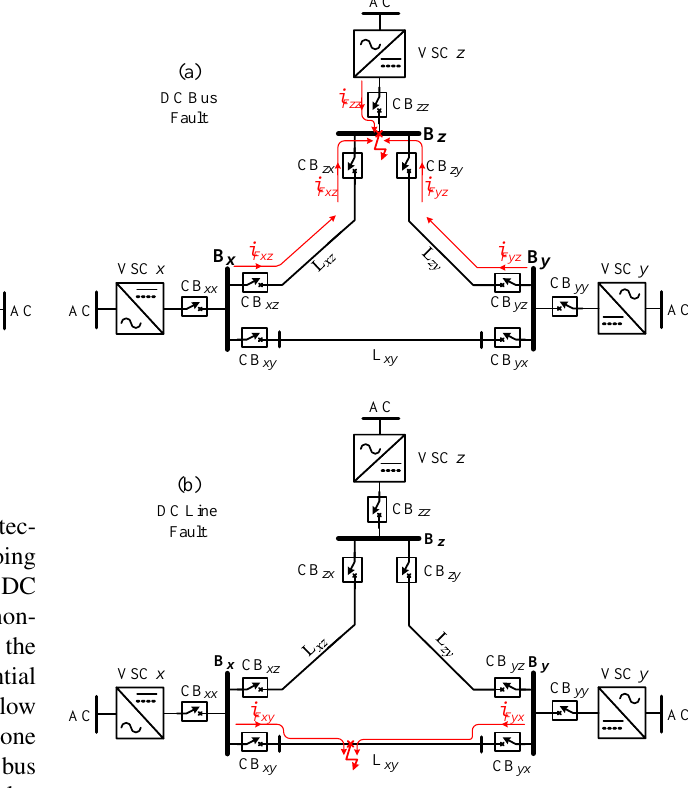
Fig. 2. UHCBs arrangement and directions and fault current directions (a) DC bus fault, (b) DC transmission line fault